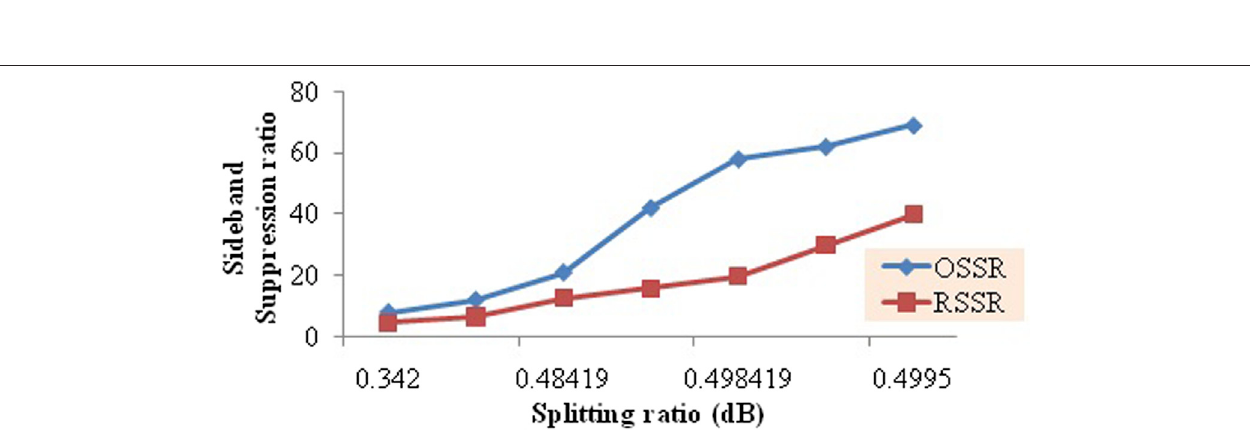
FIGURE 5 | (A) Optical spectrum when E.R. deviates by 0.010, (B) RF spectrum when E.R. deviates by 0.010, (C) optical spectrum when E.R. deviates by 0.045, and (D) RF spectrum when E.R. deviates by 0.045 value.